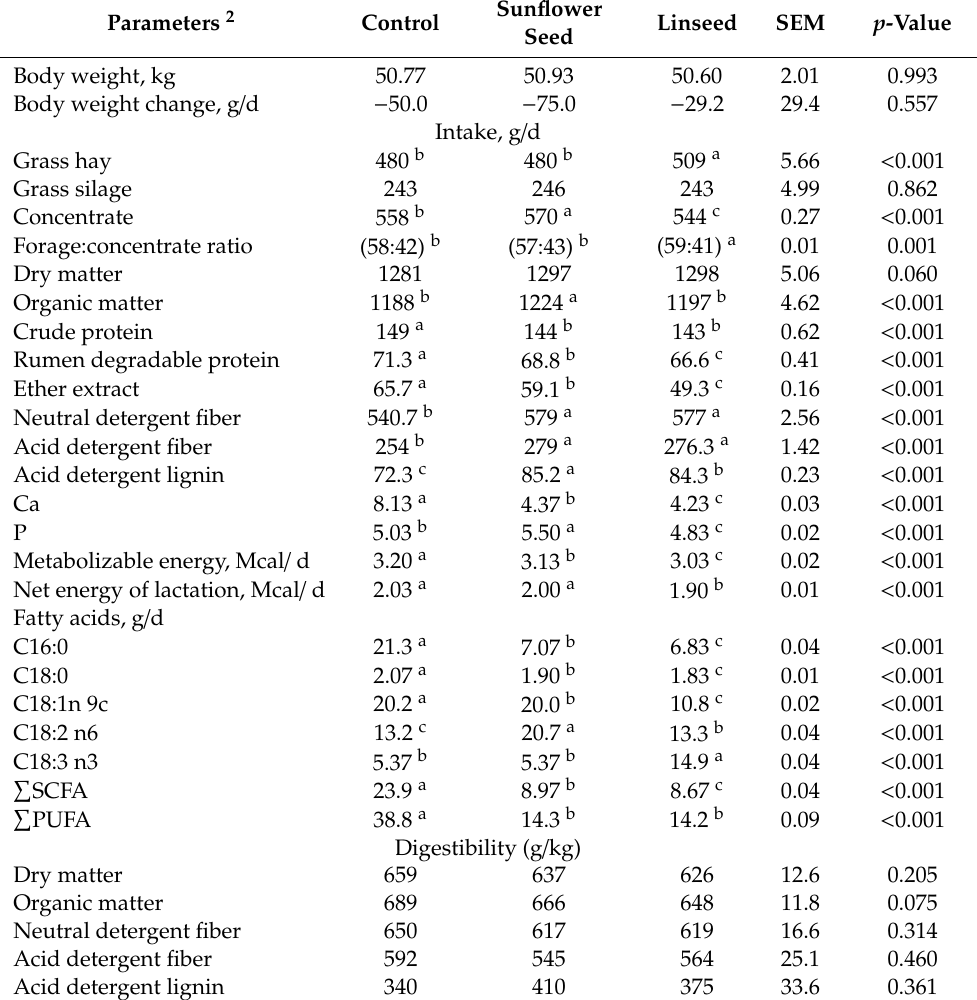
Table 3. Intake (g / d) and digestibility coe ffi cients (g / kg) in dairy goats fed control (Megalac-R ®